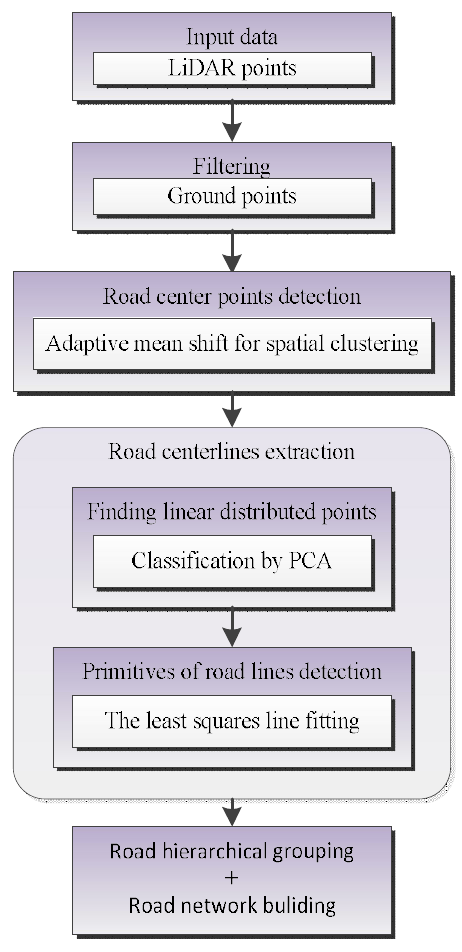
Figure 1 Workflow of the proposed road centerline extraction